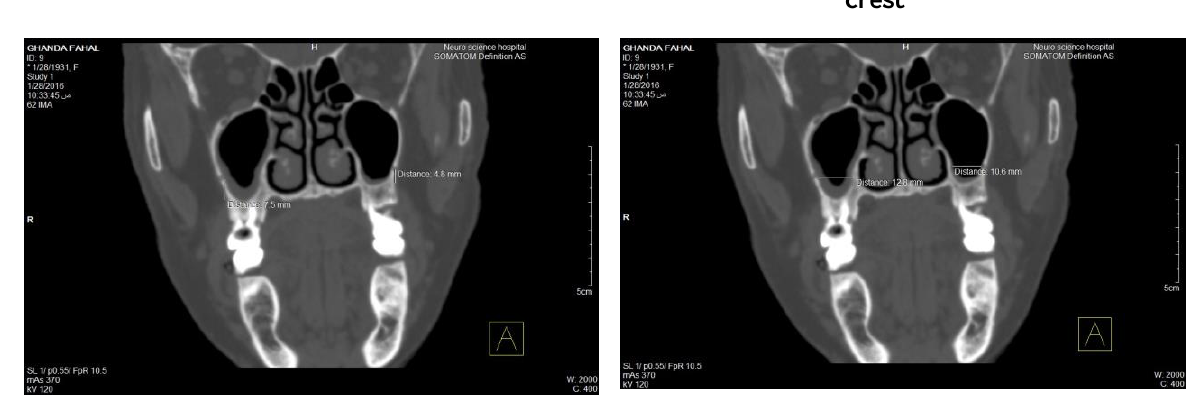
Figure 4: Coronal sections shows distance Figure 3: Coronal sections shows distance between lower borders of the posterior between lower border of the posterior superior alveolar artery to the medial sinus superior alveolar artery to the floor of the sinus